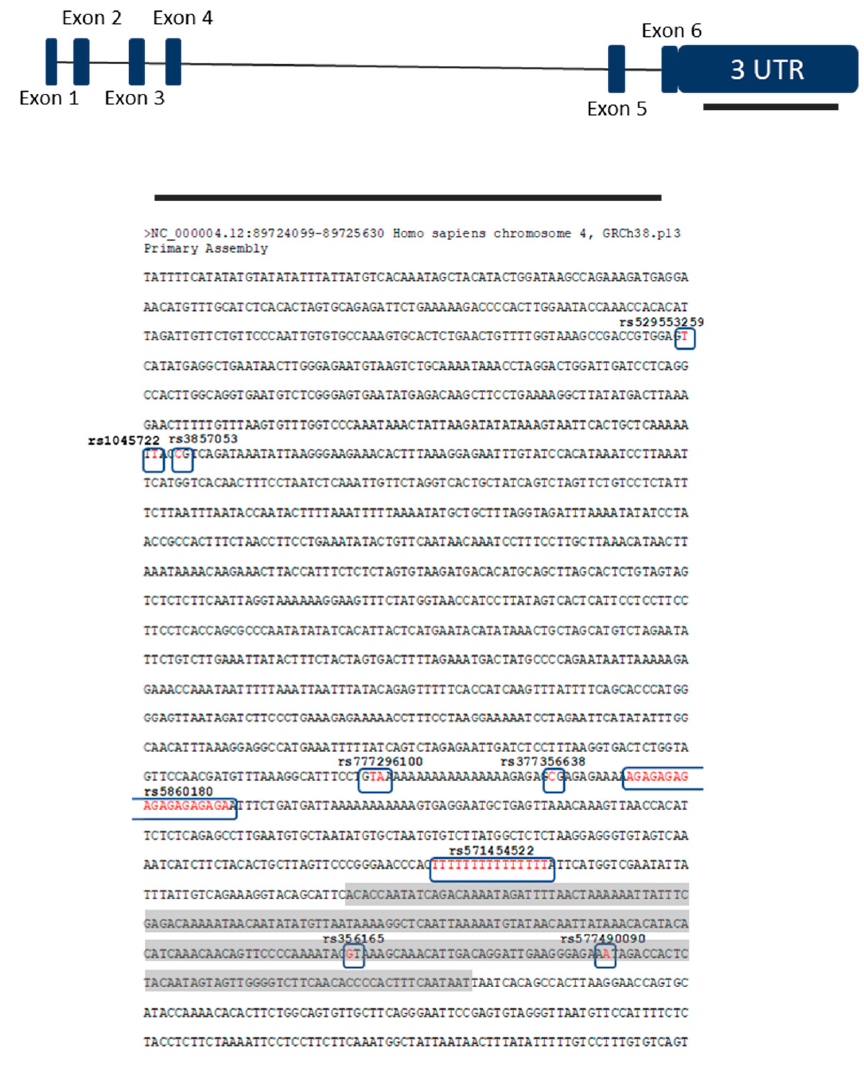
Figure 4. Part of 3 (cid:48) UTR of the SNCA gene with detected variants from our study. Red nucleotides represent altered alleles. Nucleotides highlighted in grey are the LINE element of 3 (cid:48) UTR of SNCA gene (226pb) (Sotitiou et al. 2009) .